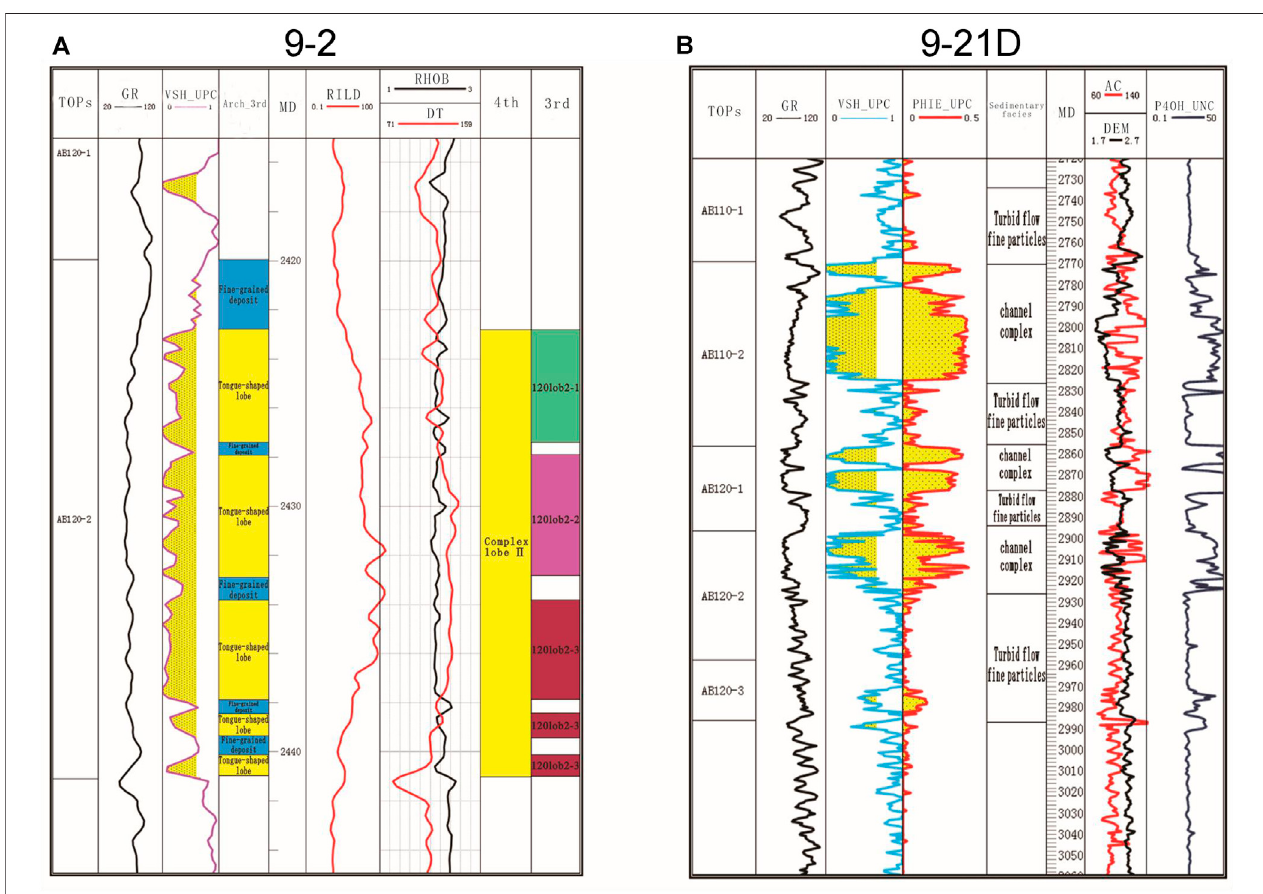
FIGURE 14 | Architectural characterization of single well. [ (A) Architectural characterization of the complex lobes in Well 9 – 2; (B) Architectural characterization of the complex channels in Well 9 – 21D).